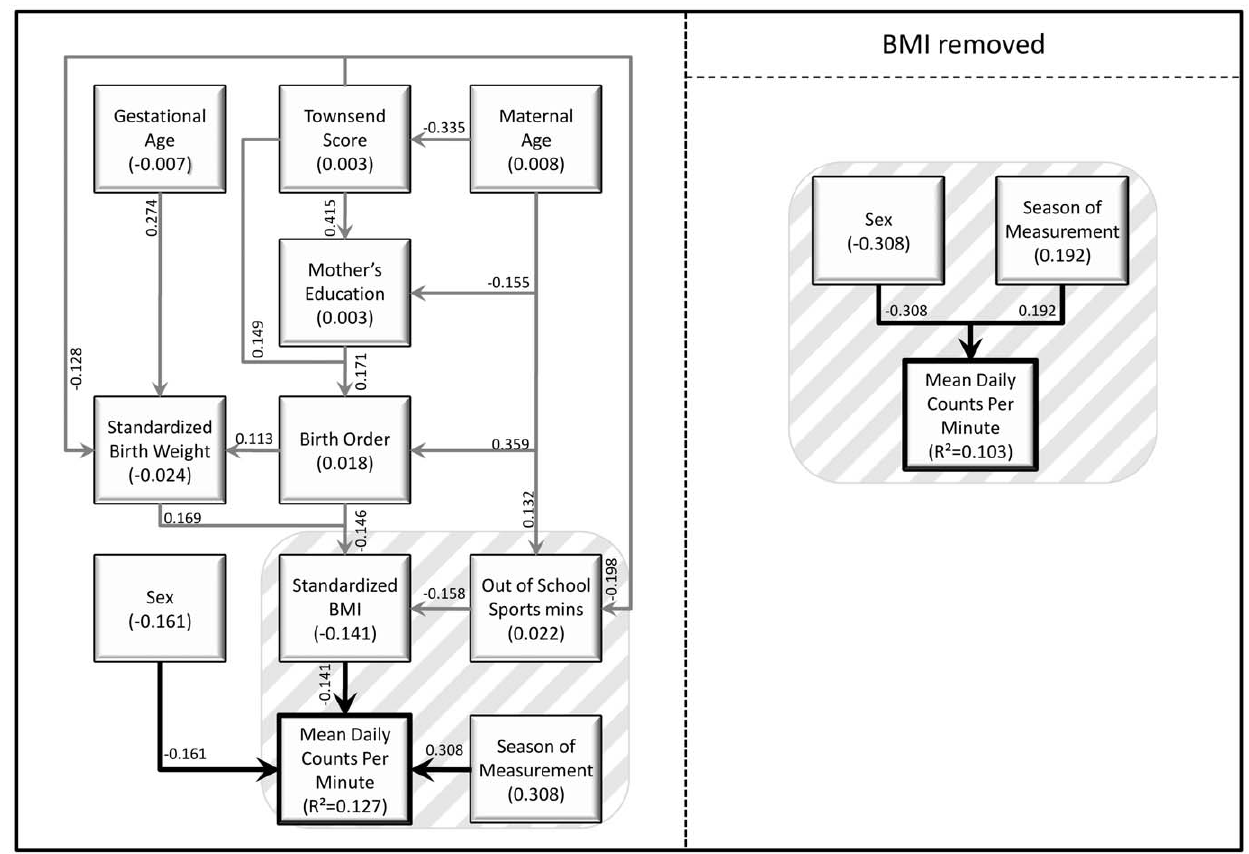
Figure 1. Path diagrams showing the direct and indirect predictors of total PA (mean daily counts per minute), with and without the inclusion of standardised BMI of the child. Significant effects (p , 0.05) are represented by solid arrows and are labelled with standardised coefficients ( b ), with the arrow direction indicating the hypothesised direction of causal flow. Indirect effects are any pathways that are mediated through at least one intermediate (eg, birth order 2. BMI 2. mean daily counts per minute). Direct effects are represented by arrows going straight from the independent variable to total PA without being mediated through another independent variable. The standardised total effect for each variable is the sum of the direct and indirect effects, and the value is shown underneath the variable name. Error terms and co-variances are omitted for simplicity.